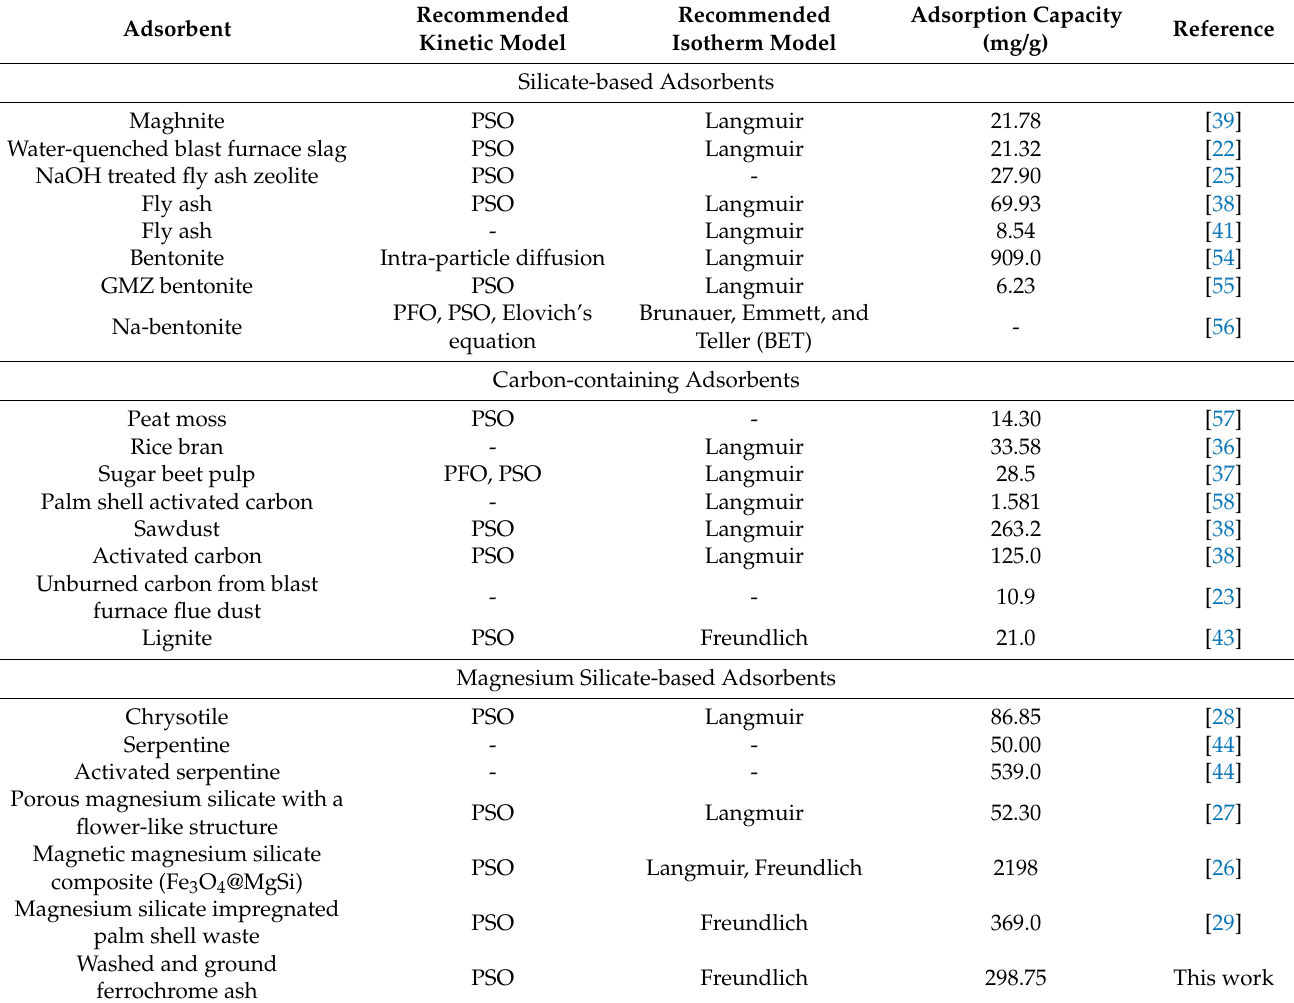
Table 3. Cu(II) adsorption capacities of varying